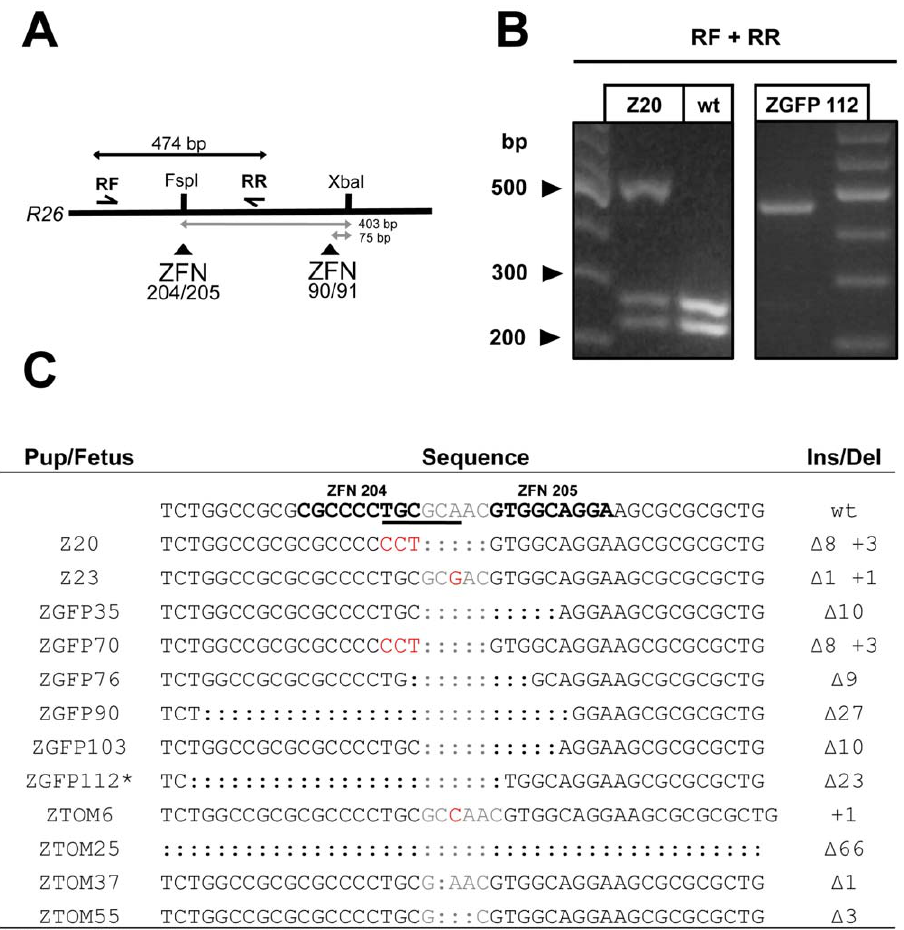
Figure 1. Non-homologous end joining repair of ZFN-generated double-strand breaks within the ROSA26 locus. (A) Schematic of ZFN 90/91 and 204/205 target sites within ROSA26 intron 1. ZFN pairs 90/91 and 204/205 target sites 75 bp and 403 bp upstream of the Xba I site (white arrows), which is routinely used in ROSA26 targeting, respectively. ZFNs 204/205 target a partial Fsp I recognition sequence. RF and RR, ROSA26 forward and reverse primers used for NHEJ analysis generating a 474 bp fragment (black arrows). (B) Screening for NHEJ repair at the ZFN204/205 cleavage site. Genomic DNA extracted from fetuses or pups developing from ZFN-injected zygotes was amplified with primers RF and RR and subjected to Fsp I restriction digest. Most error-prone NHEJ repair events eliminate the Fsp I recognition sequence (underlined in C) resulting in an indigestible band at 474 bp. In the majority of founders such as Z20 both modified and wt alleles were detected, however only mutated alleles were present in founder ZGFP112. (C) Cloning and sequencing of undigested PCR products reveals mutations around the ZFN204/205 cleavage site. Founder ZGFP112 carried an identical D 23 deletion in both ROSA26 alleles. ZFN 204/205 recognition sites highlighted in bold and the spacer region in grey